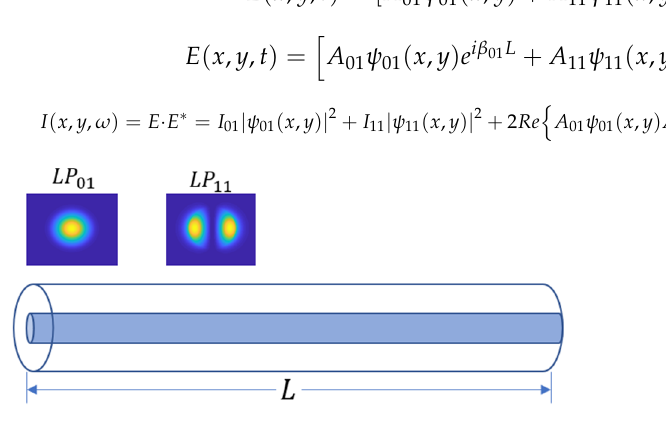
Figure 3. The FMF supports two modes ( LP 01 , LP 11 ). In (3), the optical intensity at any point in the output side of the fiber contains 2 modes of interference related to frequency. Taylor expansion (4) of the propagation constant β to the optical frequency ω is used to express the dispersion characteristics of optical fiber, which is the dependence of refractive index on optical frequency. In (4), ω 0 is the central frequency, expansion factor is β m = ∂ | ∂ω m . As illustrated in (5) and (6), the first 2 coefficients have implications, indicating that the group velocity v g is the function of wavelength λ , referred to as group velocity dispersion (GVD). The GVD leads to delay and to broaden of wave propagation, and the DMGD per unit length and unit linewidth is described in (7) by a dispersion coefficient in (ps/(km · nm)).